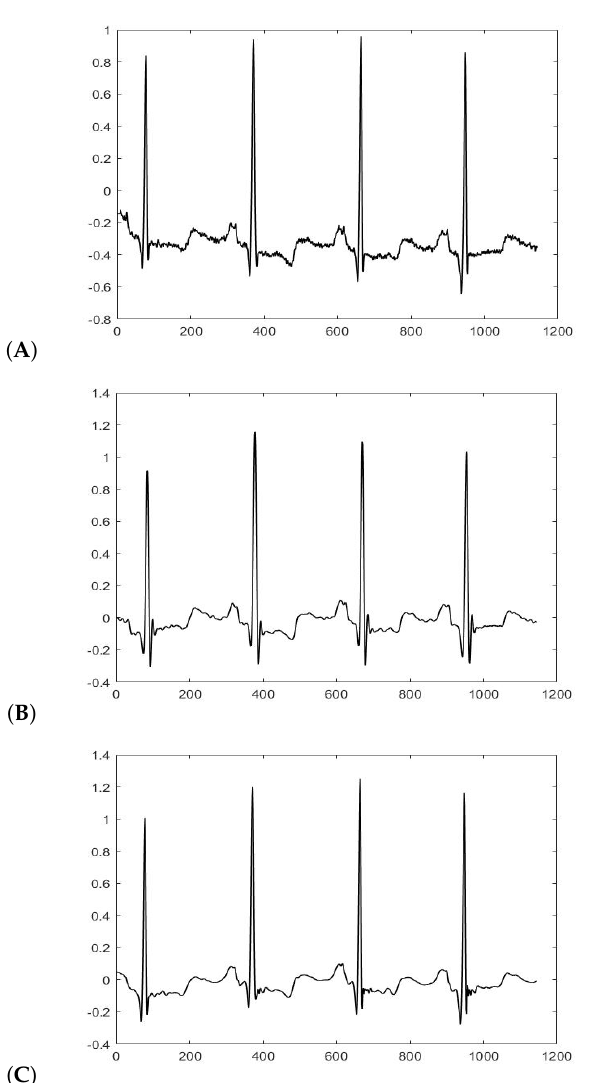
Figure 4. ( A ) Signal before the filtering. ( B ) Signal after the combination of high-pass and low-pass filtering. ( C ) Signal after the wavelet filtering